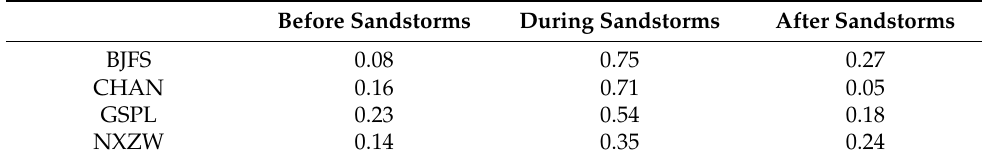
Table 2. Correlation between ZNHD and PM10 in three periods. Before Sandstorms During Sandstorms After